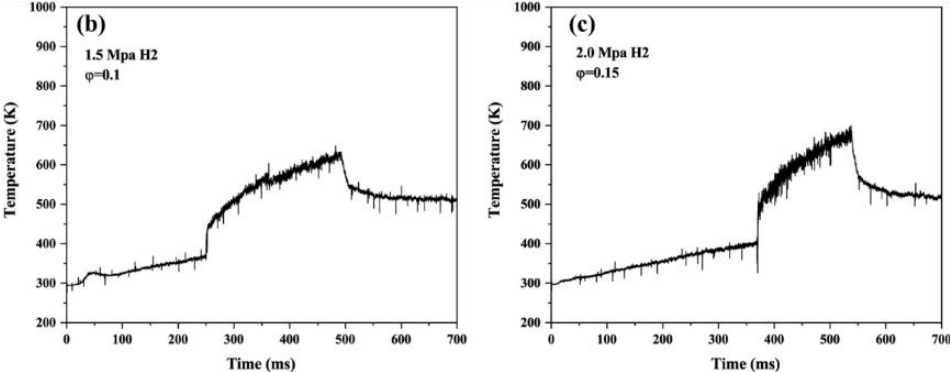
Figure 4. ( a ) The arrangement of the ITO thin-film thermocouple on the combustor wall. ( b , c ) Wall temperatures of the combustor measured by the ITO thin-film thermocouple under different cases [28]. Reprinted with permission from [28]. Elsevier, 2021.